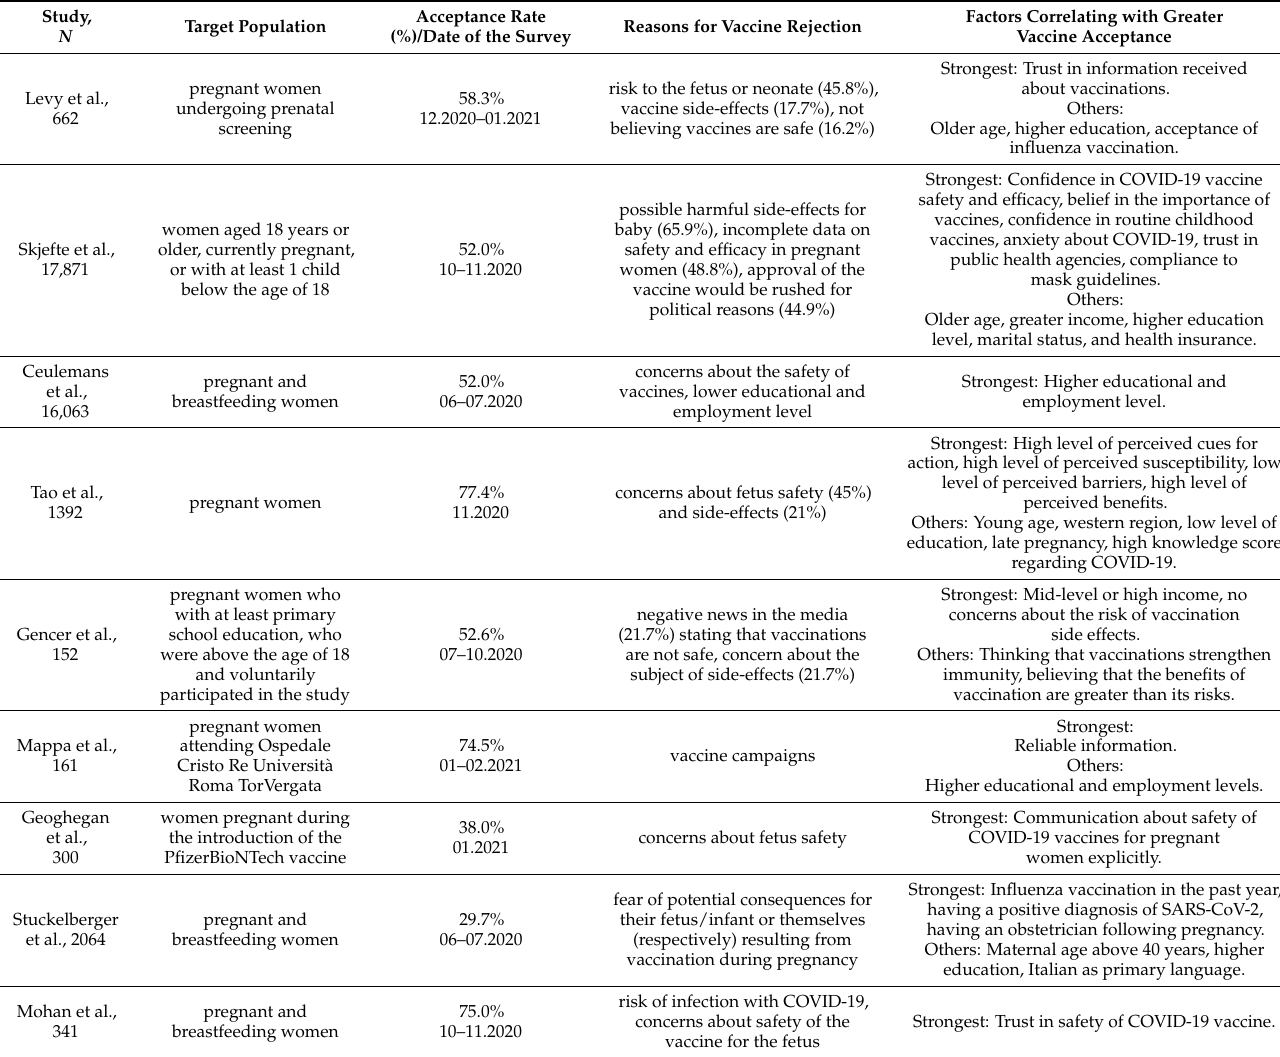
Table 2. Characteristics of vaccine acceptance among pregnant